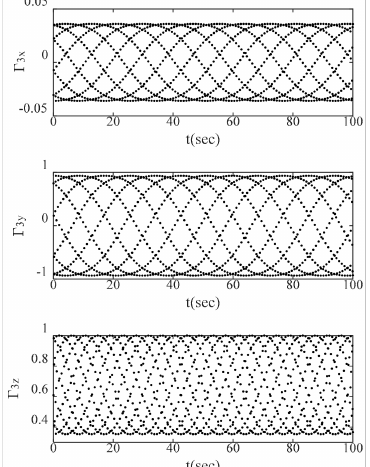
Figure 23. The results of the attitude of the x axis under the complete Lie group